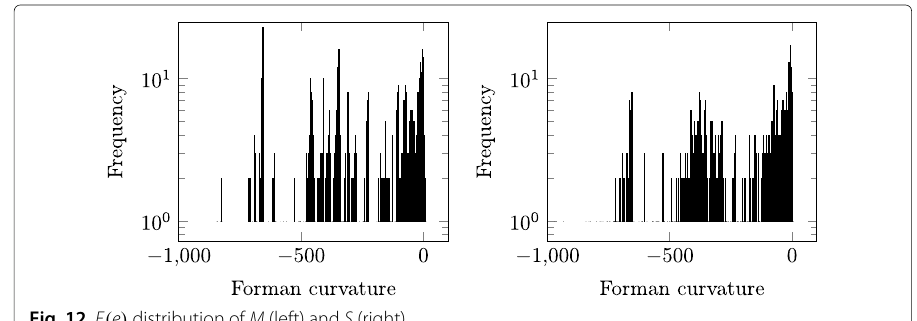
Fig. 12 F ( e ) distribution of M (left) and S (right)